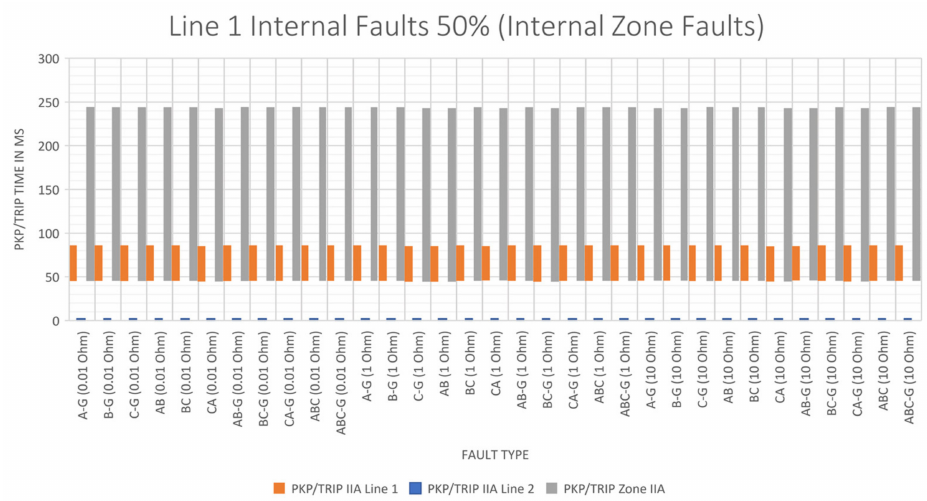
Figure 21. Internal line faults in Line 1 (50%); four